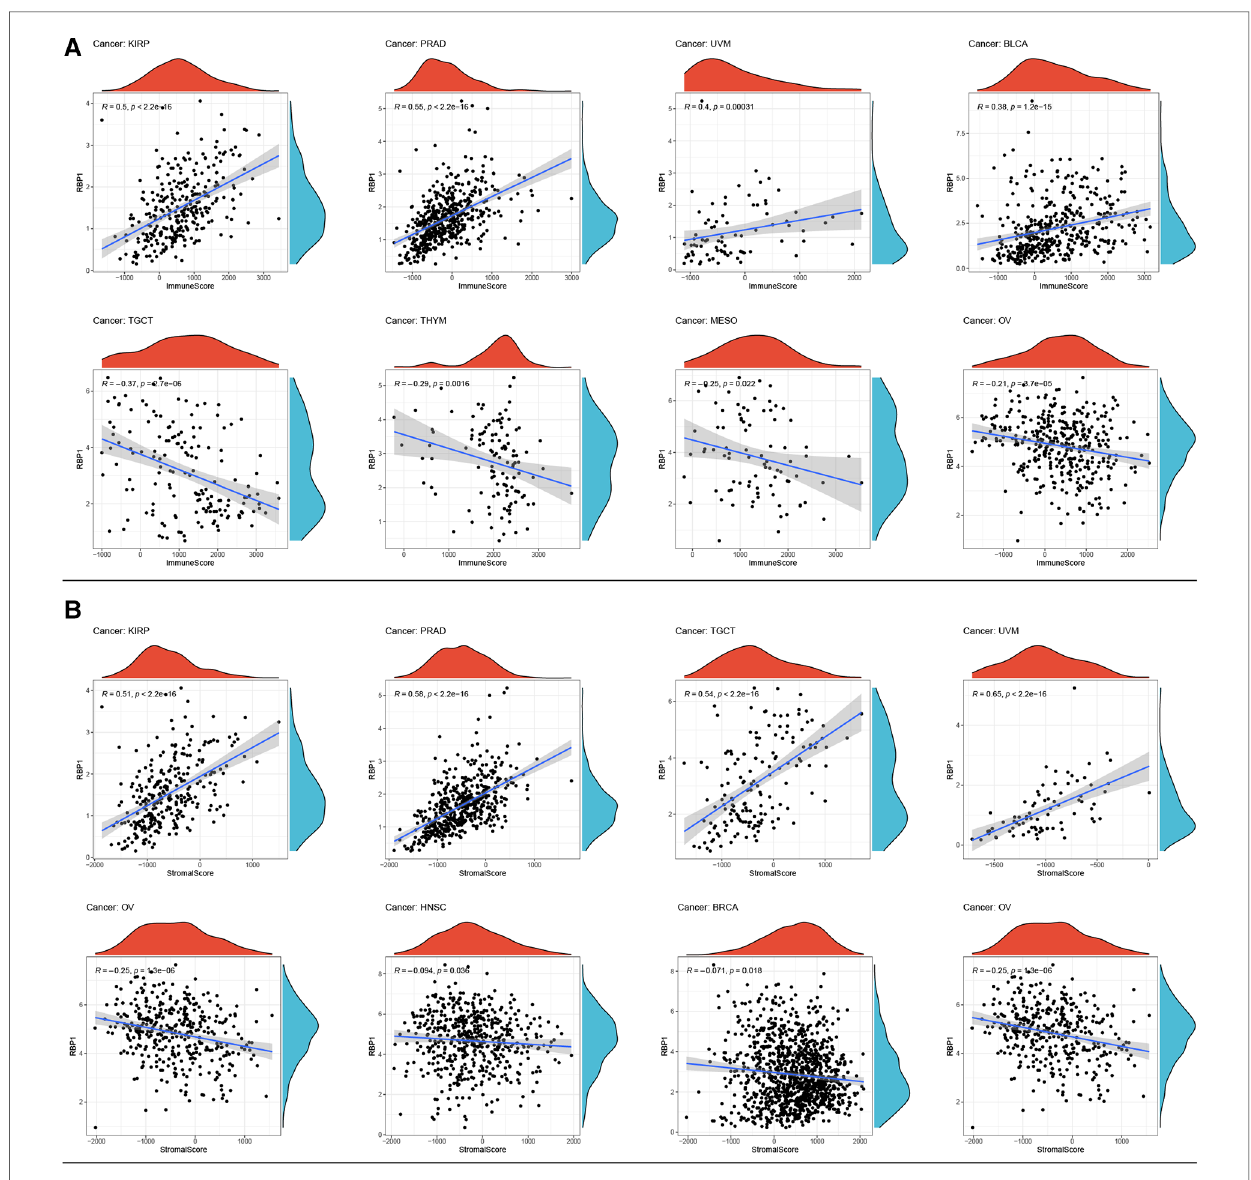
FIGURE 8 Analysis of RBP1 ’ s relationships with ImmuneScore and StromalScore. (A) Results of correlation analysis of RBP1 with ImmuneScore. ( B ) Correlation analysis of RBP1 with